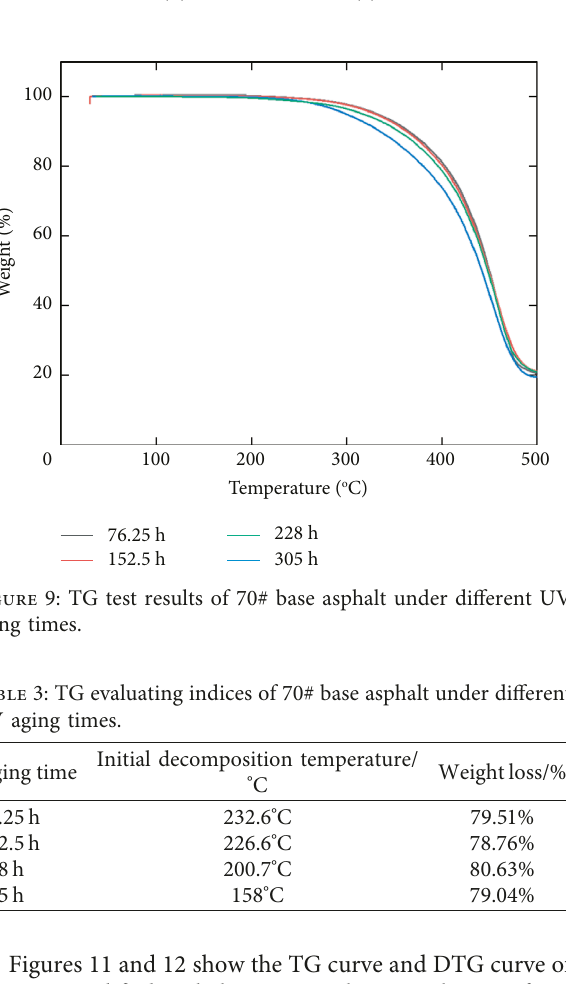
Figure 8: ASA-modified asphalt under different UV aging times of microscopic morphology. (a) 76.25 h-200 times. (b) 152.5h-200 times. (c) 228h-200 times. (d) 305h-200 times. (e) 76.25h-2000 times. (f) 152.5h-2000 times. (g) 228h-2000 times. (h) 305h-2000 times.